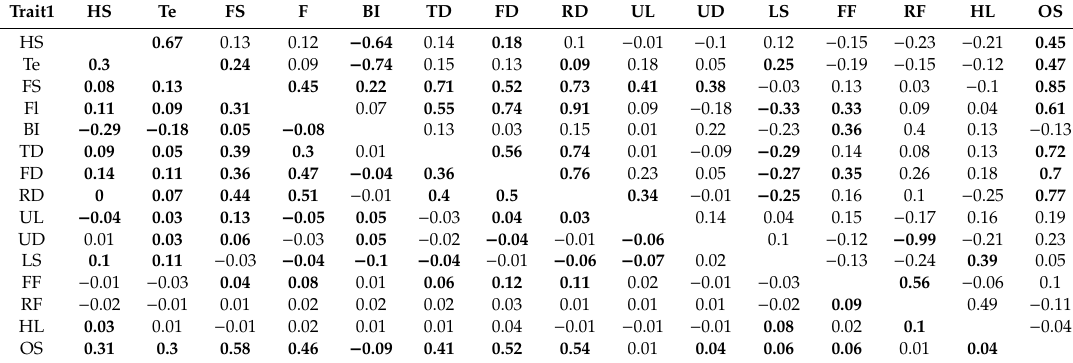
Table 4. Estimates of genetic correlations (above diagonal) and phenotypic correlations (below diagonal), between each trait pairs considered in the study. Significant correlations are bolded. Standard errors of traits are reported in an extended version of table (Supplementary Table